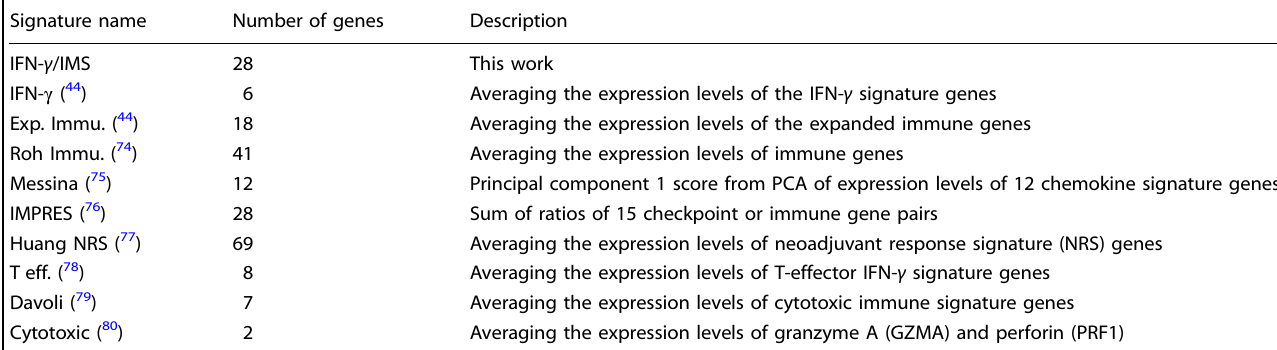
Table 1. GEP signatures used in this study.